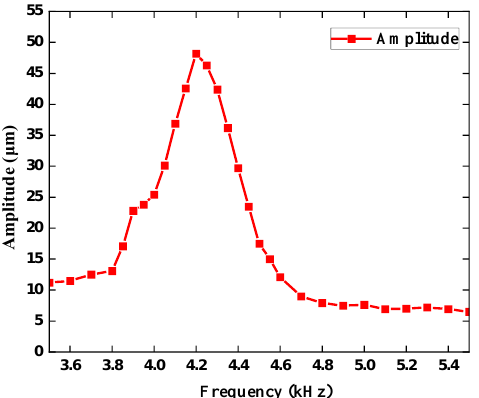
Figure 8. The amplitude curve of the piezoelectric vibrator.